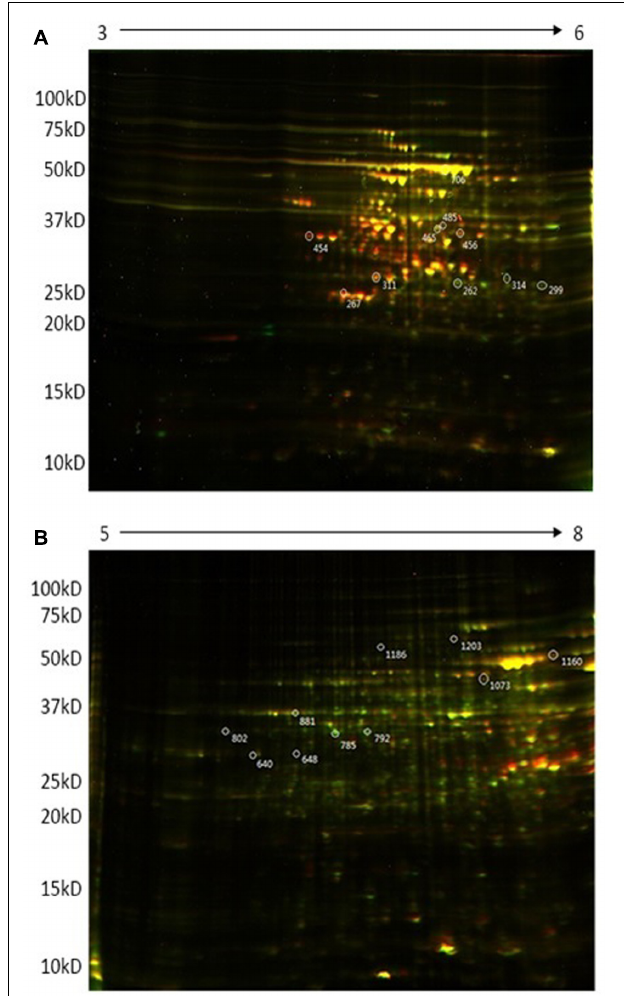
FIGURE 1 | Representative 2D-DIGE expression maps of Rhizobium leguminosarum bv. viciae 3841 (wt) and 3845 ( ctpA mutant) labeled with Cy3 (green) and Cy5 (red), respectively. First dimension in (A) is pH 3-6 and in (B) is pH